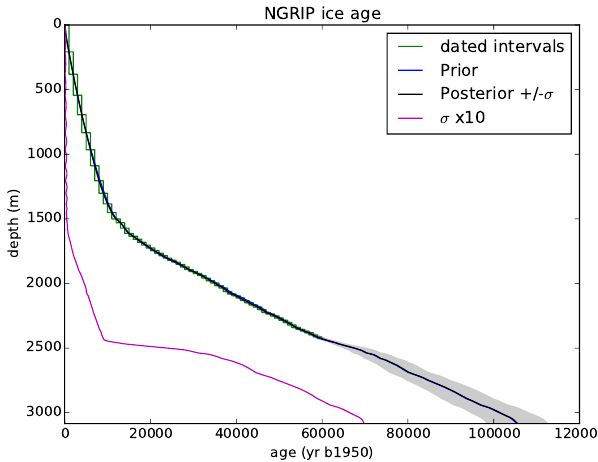
Figure 7. Experiment test-ice-intervals-with-known-durations- with-correlation. NGRIP prior (blue) and posterior (black) chronologies and the posterior confidence interval (grey area) when using correlated 1kyr long intervals with known durations from the GICC05 layer-counted timescale (green rectangles; Svensson et al., 2008). The 1 σ uncertainty of the posterior timescale is also shown on the left (pink). This figure is automatically produced by IceChrono1.